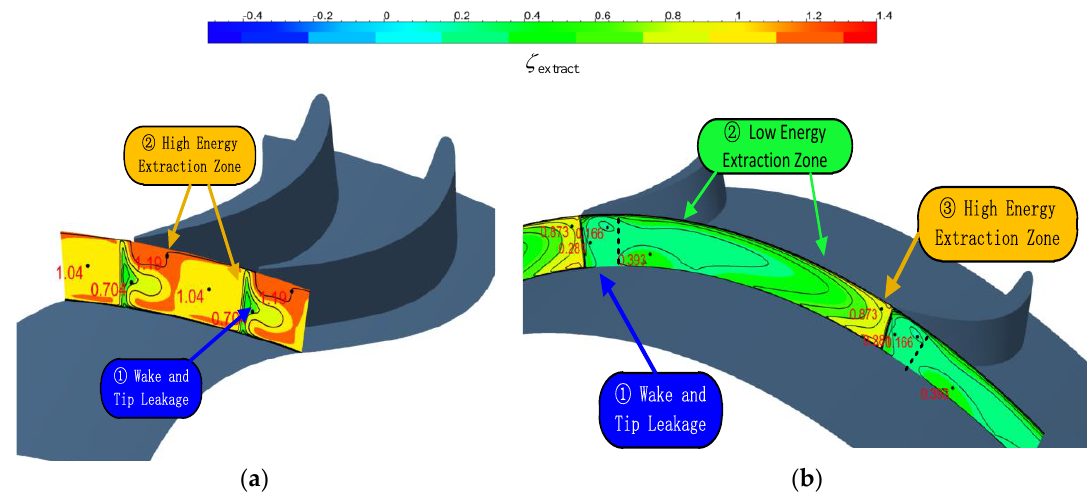
Figure 7. Energy extraction rate distributions of the tip turbines: ( a ) conventional solidity; ( b ) low solidity.